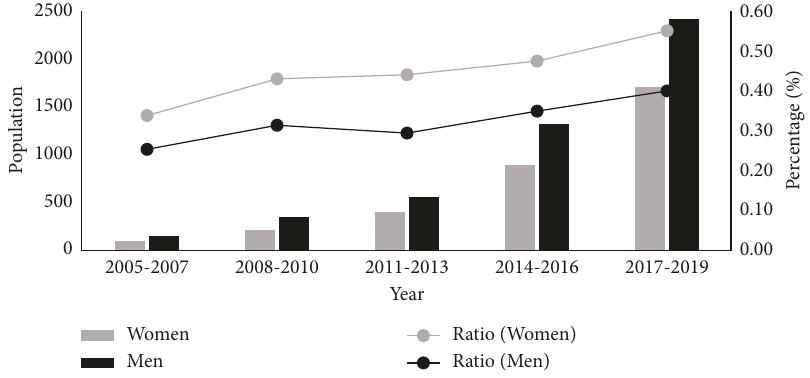
Figure 2: Temporal trends of the CHA